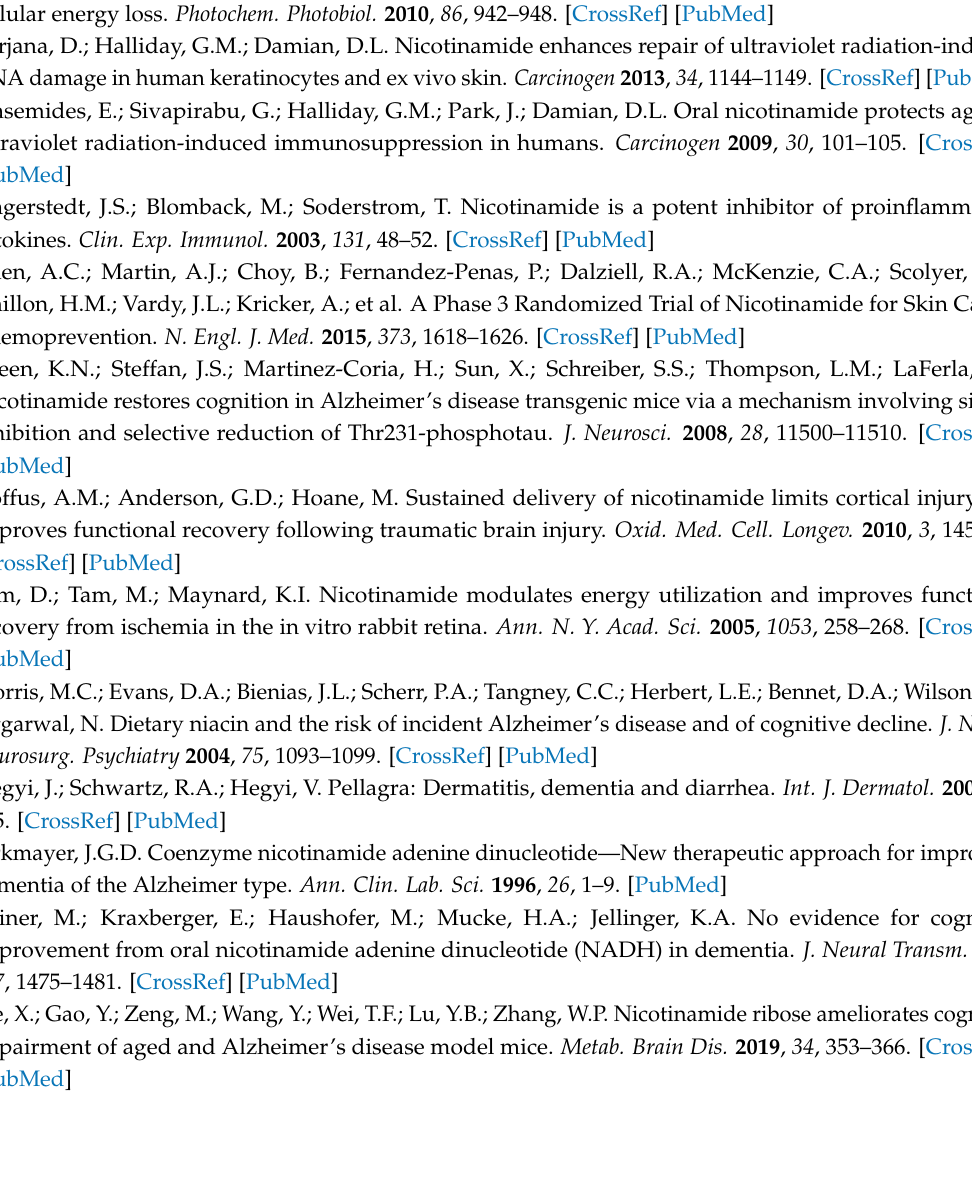
Figure S1: CONSORT diagram for neurocognitive function (NCF) testing of ONTRAC participants; Figure S2: CONSORT diagram for Quality of Life (QoL) assessment of ONTRAC